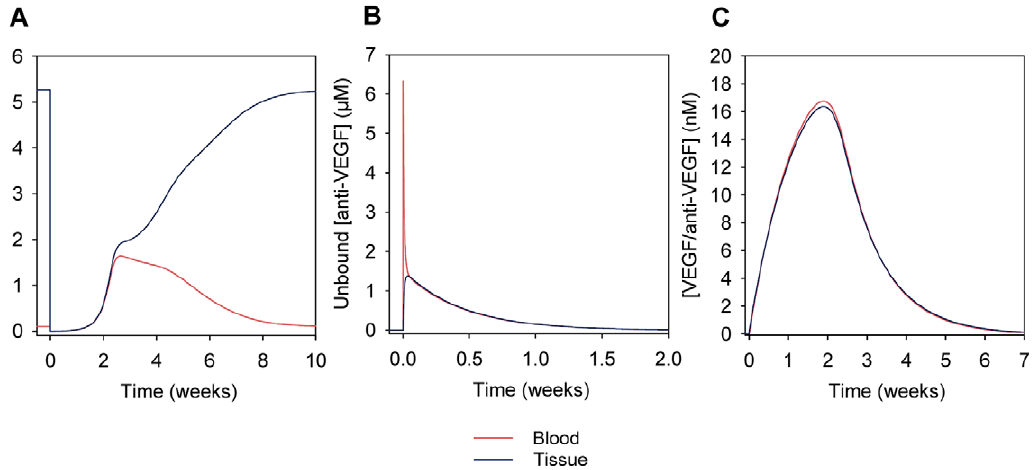
Figure 4. Concentration profiles following the injection of the anti-VEGF agent (VEGF Trap). A 25 mg/kg injection of anti-VEGF in the blood at time 0 was simulated using the optimized parameters. The profiles of (A) unbound VEGF, (B) unbound anti-VEGF, and (C) VEGF/anti-VEGF complex are shown in the blood (red) and tissue (blue) compartments. In (A), VEGF level in the tissue drops significantly after injection. Blood VEGF concentration increases to levels greater than steady-state reaching a maximum at 2.7 weeks post-injection, and returns to original steady-state levels by approximately 10 weeks after injection. Note that the axes of the panels are on different scales. doi:10.1371/journal.pone.0027514.g004 PLoS ONE |